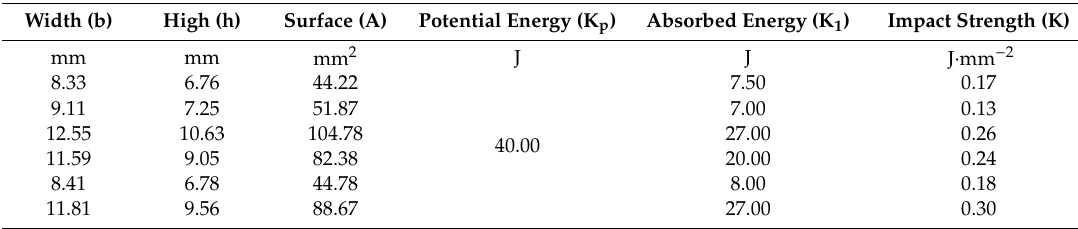
Table 6. Impact strength of Miscanthus × giganteus .